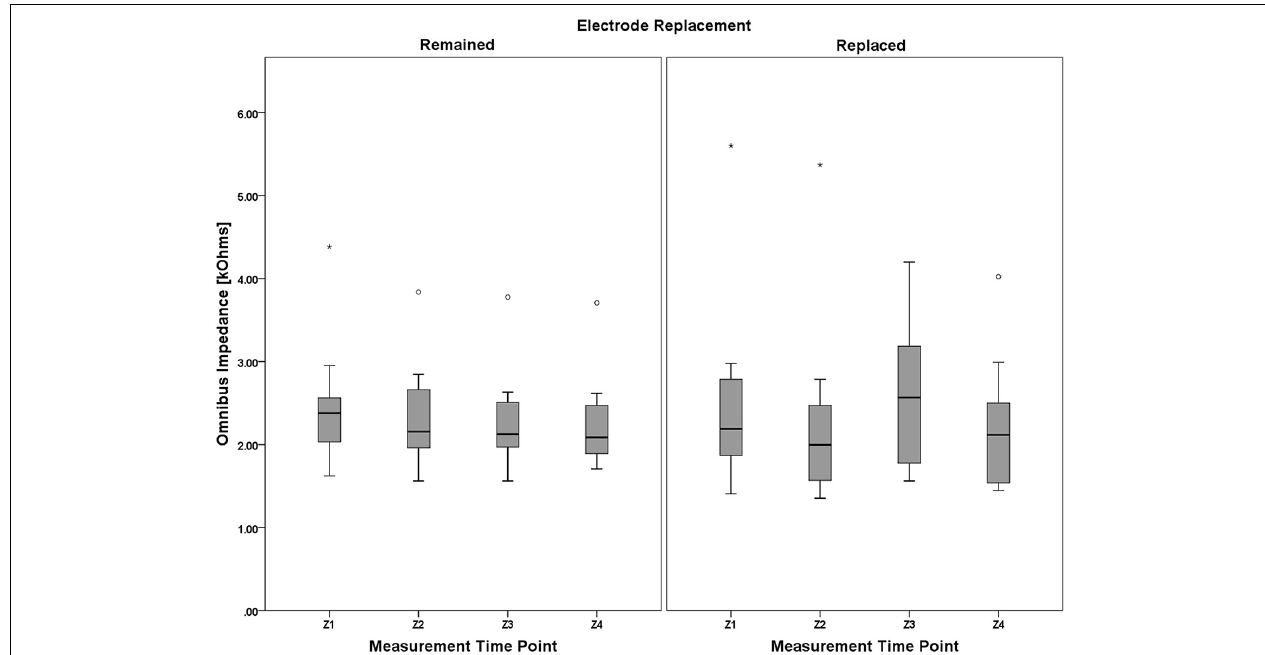
FIGURE 10 | Boxplots showing omnibus impedance data representative of the 4 (measurement time point, within) × 2 (electrode replacement, between) mixed model ANOVA results. It is worth noting that, despite the lack of main effect of measurement time point and electrode replacement, or a significant interaction between the two factors, (1) impedance for the Remained group appears to very slightly decrease over the course of the protocol, and (2) this decreasing trend was interrupted by electrode replacement in the Replaced group (although still apparent between Z1/Z2